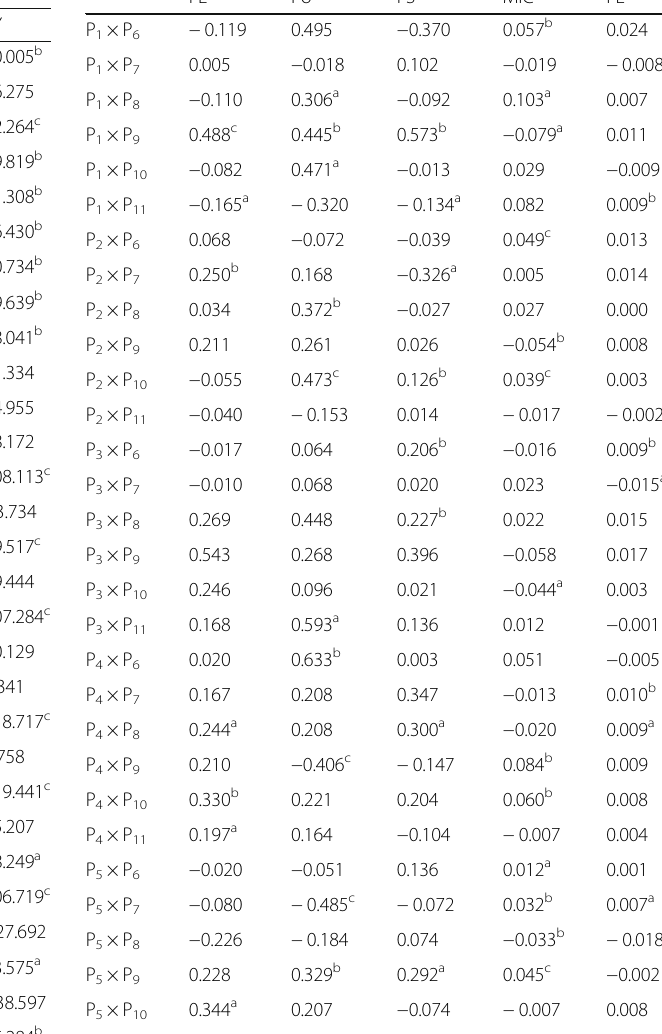
Table 3 Predicted dominant effects for fiber quality